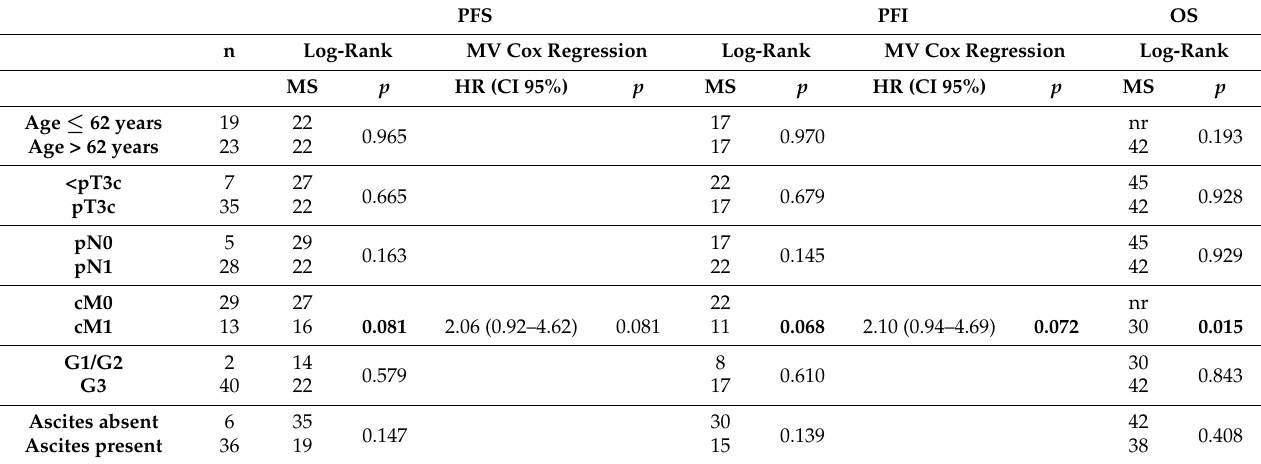
Table 3. Univariate and multivariate survival analysis of clinicopathological factors and integrin α 2 β